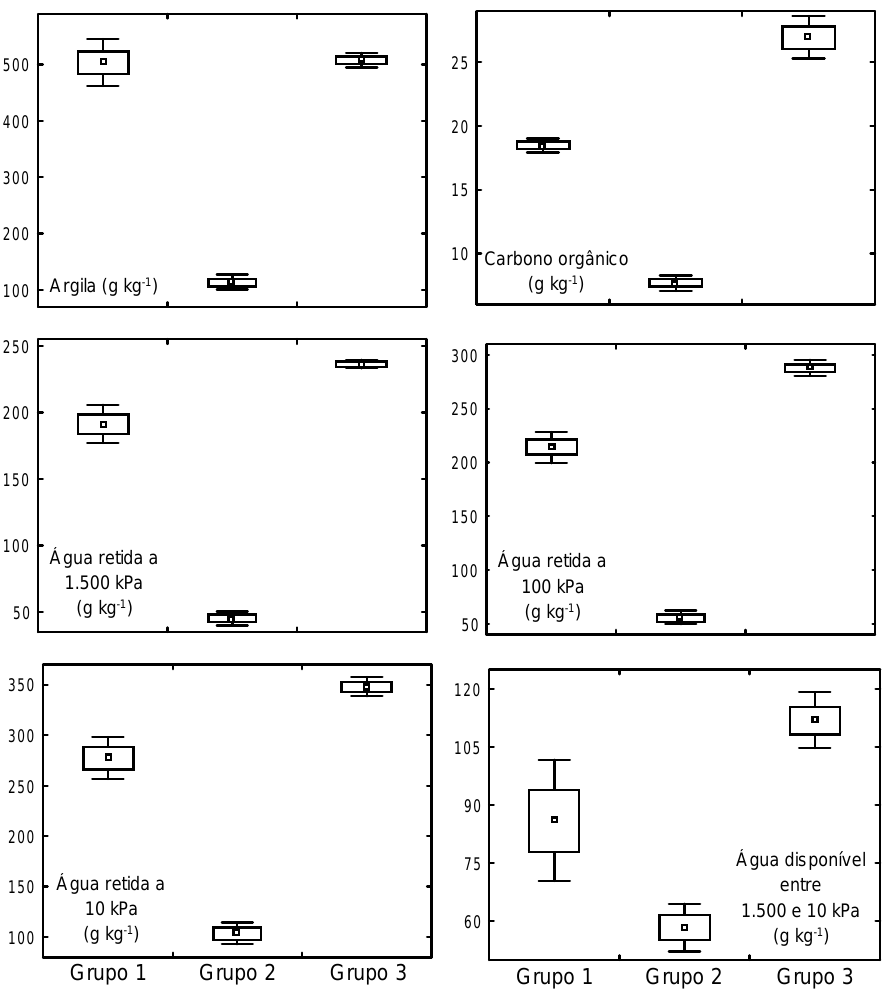
Figura 3. Médias, erro-padrão (box) e intervalo de confiança (erro-padrão ××××× 1,96) de variáveis relacionadas com a retenção de água pelo solo para as amostras de horizontes superficiais dos grupos de perfis de solo: 1 = solos de textura argilosa a muito argilosa, hipo a mesoférricos; 2 = solos de textura média a arenosa, hipoférricos; 3 = solos de textura argilosa a muito argilosa,